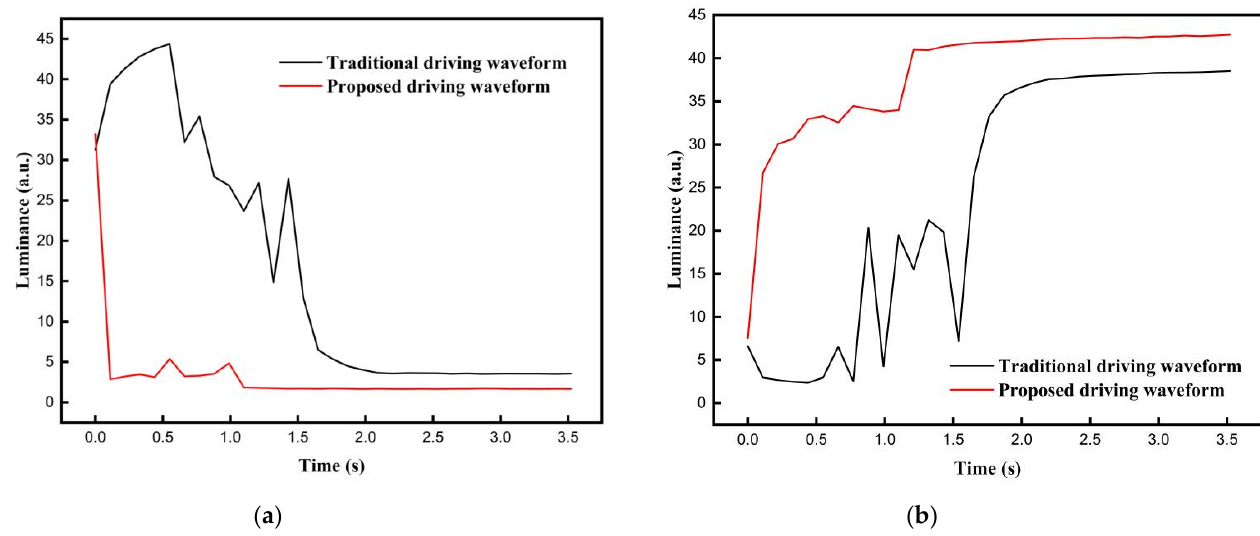
Figure 8. The grayscale conversion process of the three-color EPD. ( a ) It was driven by the traditional driving waveform and the target grayscale was black. ( b ) It was driven by the proposed driving waveform and the target grayscale was black. ( c ) It was driven by the traditional driving waveform and the target grayscale was white. ( d ) It was driven by the proposed driving waveform and the target grayscale was white.